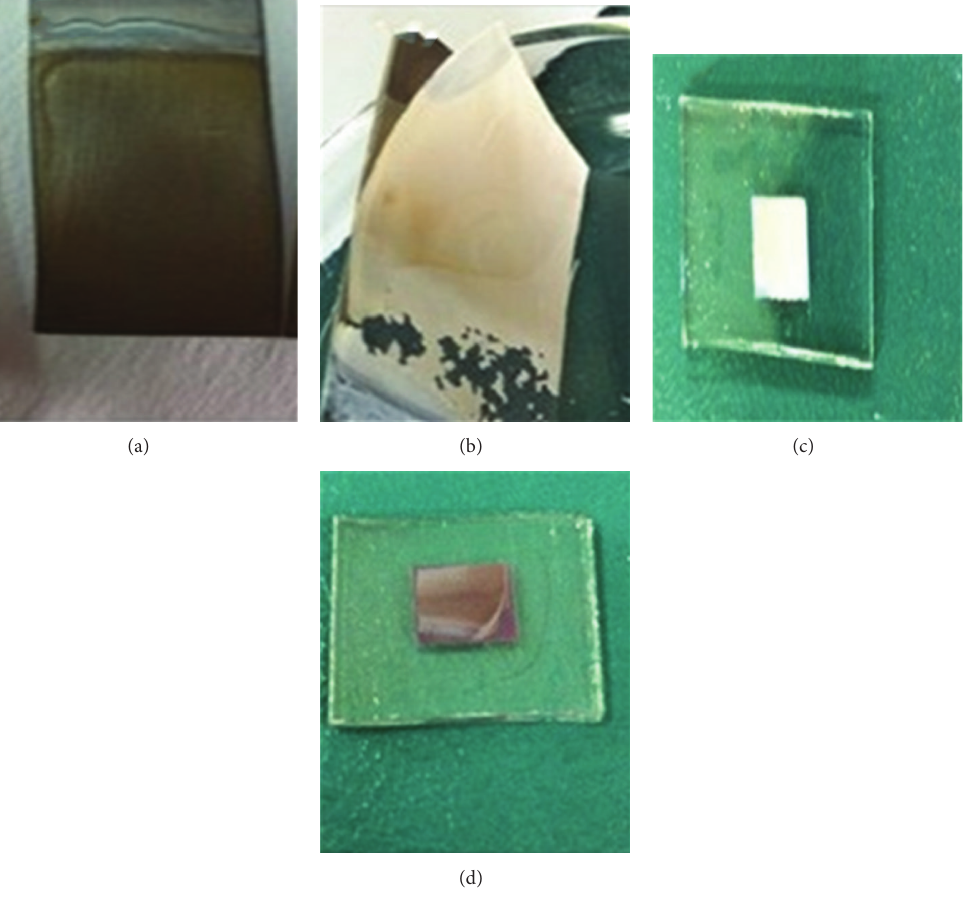
Figure 1: Photographs of TNT-arrays at different fabrication stages: TNT-arrays on the Ti substrate via anodization method (a), TNT-arrays membrane detached from the Ti substrate via a secondary anodization method (b), crystalline TNT-arrays/FTO film after heat treatment before dye loading (c), and N719 dye loaded TNT-arrays/FTO film (d).